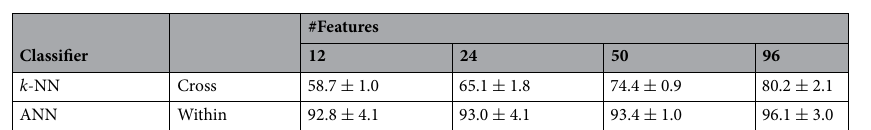
Table 7. Accuracy performances of the best processing solutions for both within- and cross-subject approaches at varying the number of input features selected through the mutual information